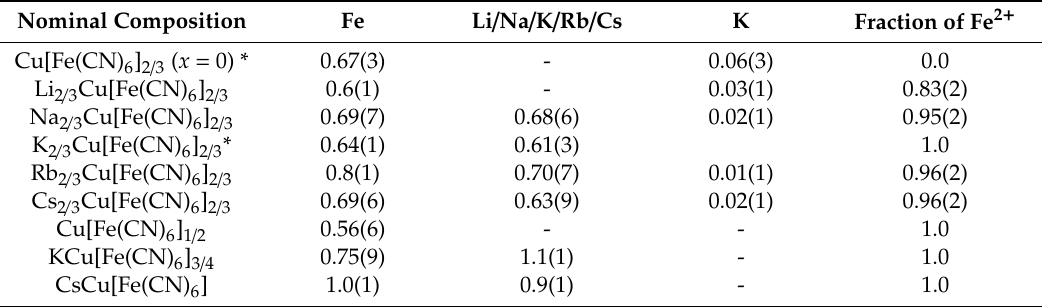
Table 1. Cation compositions determined from EDS analysis, normalized to a Cu amount of one, and the fractions of Fe 2 + from IR